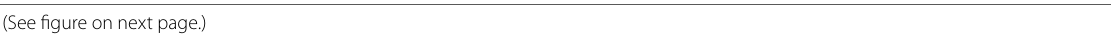
figure on next Fig. 3 Inflammation-based subtypes are associated with distinct tumor microenvironment. A and B Violin plots showing the median, quartile, and kernel density estimations for each immune score ( A ) and tumor purity score ( B ). C Relative proportion of immune infiltration in LGG samples. D and E Boxplots representing the differential distribution of immunoreactive, immunosuppressive cells ( D ) and immune checkpoints ( E ) in the various inflammation